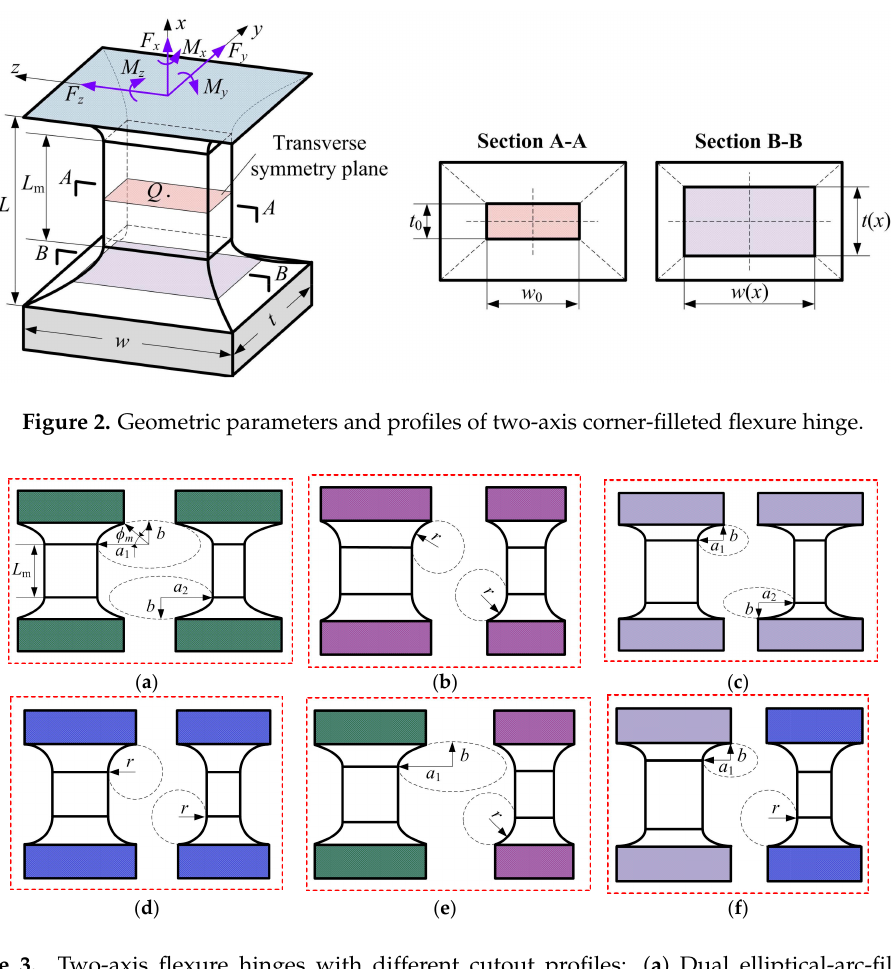
Figure 3. Two-axis flexure hinges with different cutout profiles: ( a ) Dual elliptical-arc-filleted (DEAF); ( b ) Dual circular-arc-filleted (DCAF, a 1 = a 2 = b = r ); ( c ) Dual elliptical-filleted (DEF, φ m = π /2); ( d ) Dual right-circular-filleted (DRCF, a 1 = a 2 = b = r and φ m = π /2); ( e ) Hybrid elliptical-arc-filleted and circular- arc-filleted (HEACF, a 1 = b = r or a 2 = b = r ); ( f ) Hybrid elliptical-filleted and right-circular-filleted (HERCF, a 1 = b = r or a 2 = b = r and φ m = π /2).